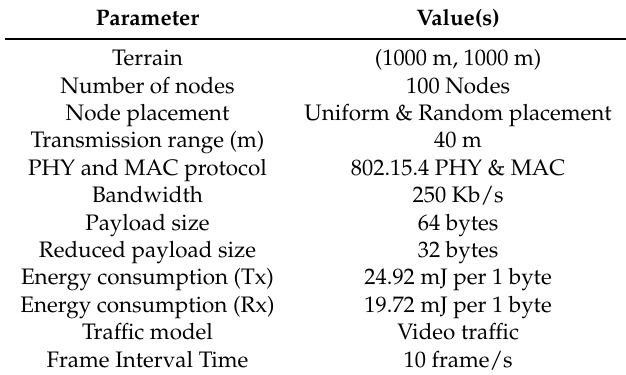
Table 1. Simulation environment